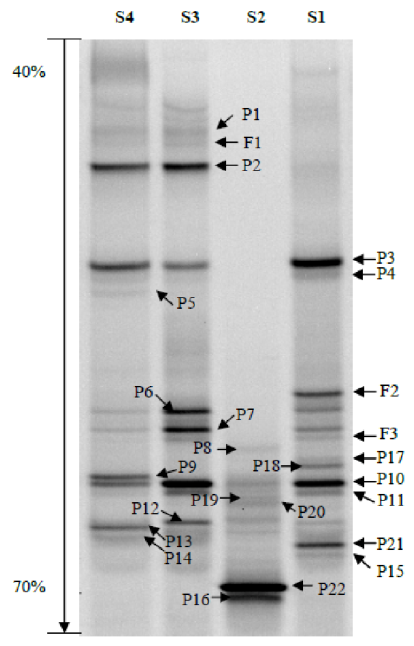
Figure 1. Denaturing gradient gel electrophoresis (DGGE) profiles of nested PCR-amplified 16Sr RNA gene fragments of bacteria from the guts of Dendroctonus armandi larvae ( lane S1 ), pupae ( S2 ), adult females ( S3 ), and adult males ( S4 ). Bands P1–P22 and F1–F3 represent 16S rRNA gene regions of different bacteria.